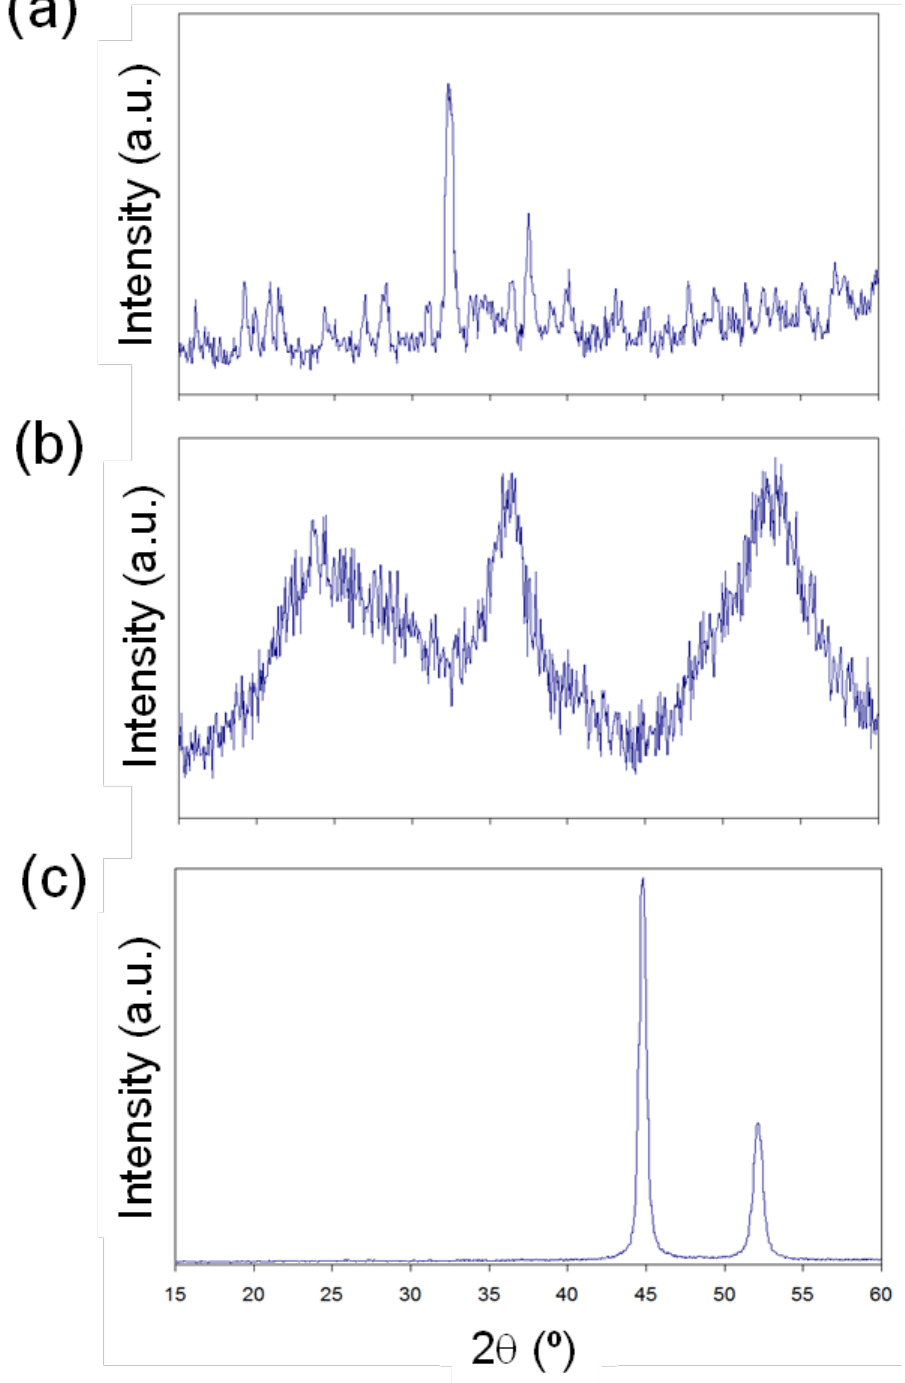
Figure 3. XRD spectra of ( a ) CoP, ( b ) MoP, and ( c ) NiP.